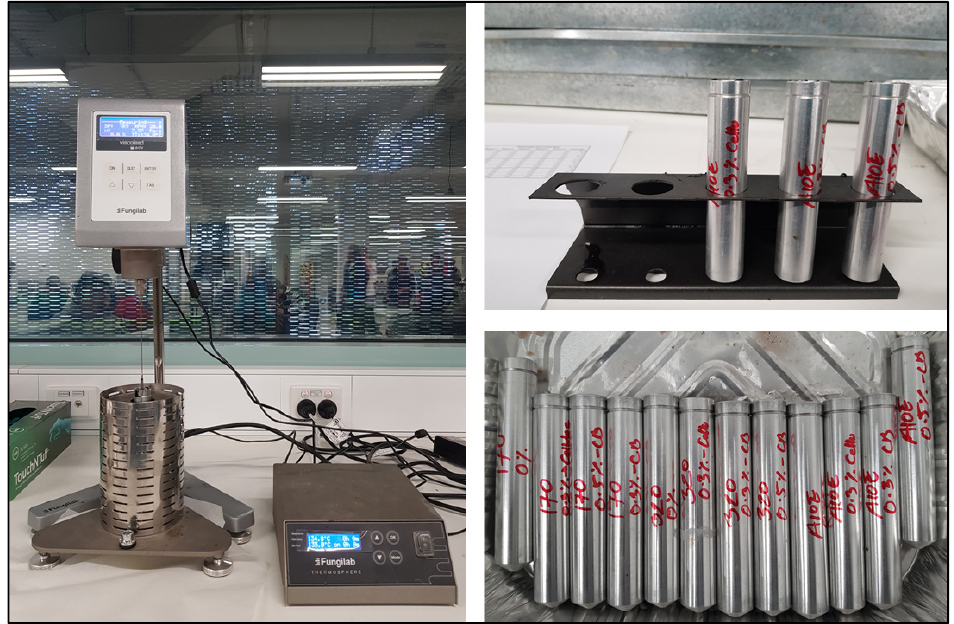
Figure 9. Viscosity test of samples used in this study. Use of rotational viscometer to assess viscosity (left); cylindrical containers used to store and perform viscosity test of bitumen (right).